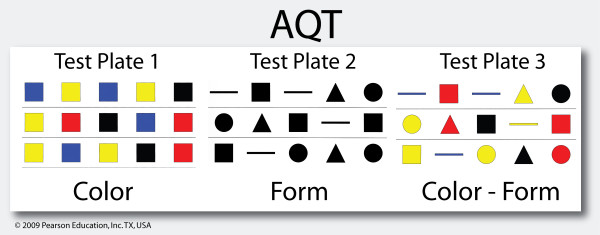
A sample of AQT. Each original test plate contains 40 figures. The patient is instructed to quickly name the color of each figure on the first test plate (AQT-C), the form on the second plate (AQT-F), and the color and form on the third plate (AQT-CF) [8]. Only AQT-CF results were analyzed in this study.